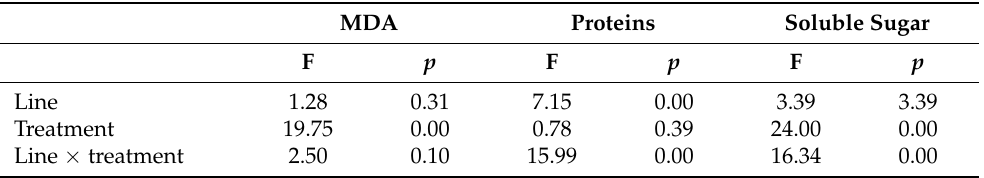
Table 5. Effects of line, treatment, and the interaction line x treatment on biochemical parameters for studied lines of M. truncatula under control treatment and drought stress.